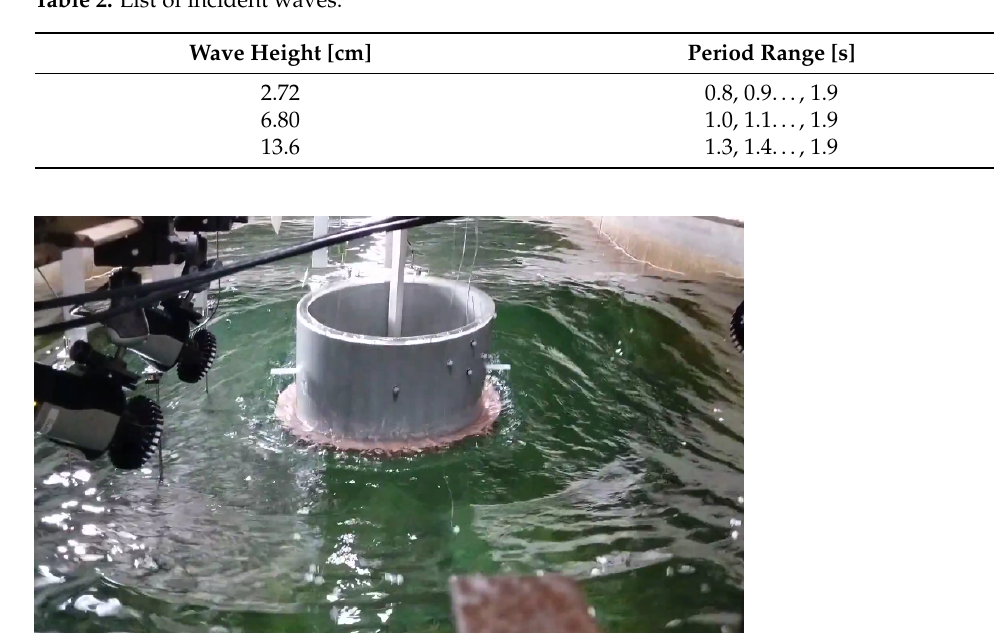
Table 2. List of incident waves.